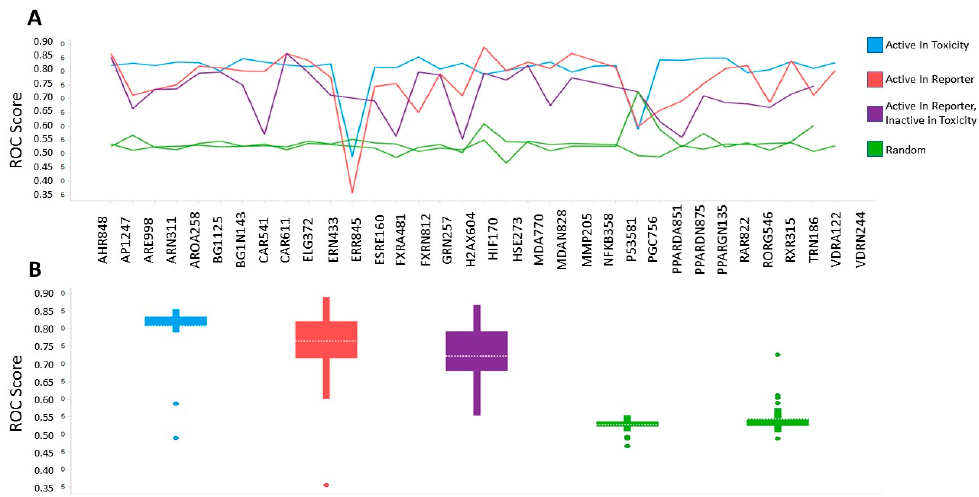
Figure 2. Benchmarking Machine Learning Results. ( A ) Compounds were evaluated for active versus inactive class in three distinct categories (see text for details) based on their chemical structures. Receiver operating characteristic (ROC) scores were calculated based on leave one out cross validation. Results for randomized labels are shown in green. ( B ) Box plots indicate overall ROC score distribution for each category; arithmetic means are indicated by dashed lines; error bars = standard deviation.